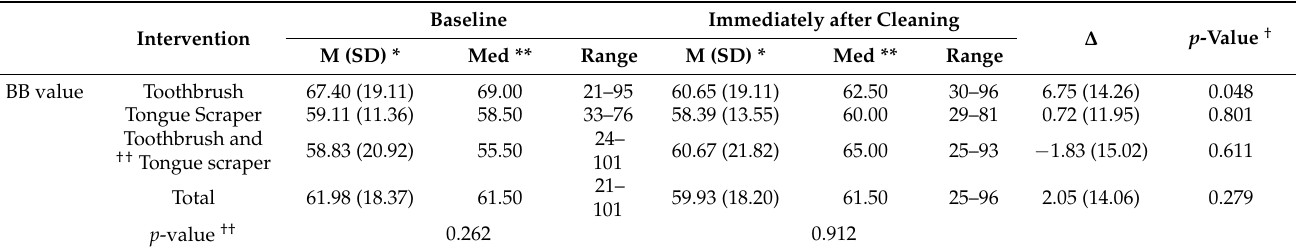
Table 10. Portable sulfide monitor score (BB value).